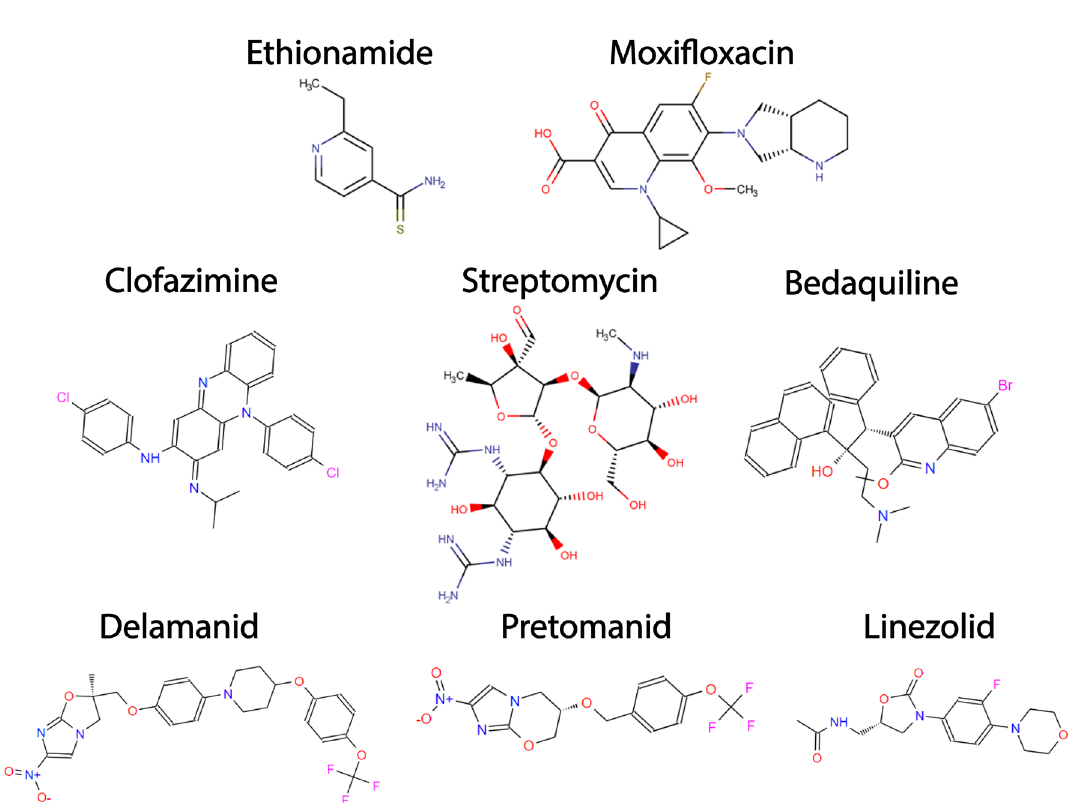
Figure 2 - Second-line drugs used in tuberculosis treatment. Structures for some second-line drugs used in tuberculosis treatment, Ethionamide, Moxifloxacin (Fluoroquinolone), Clofazimine, Streptomycin (injectable aminoglycoside), Bedaquiline, Delamanid, Pretomanid and Linezolid Structures were drawn using Marvin software (Cherinka et al .,